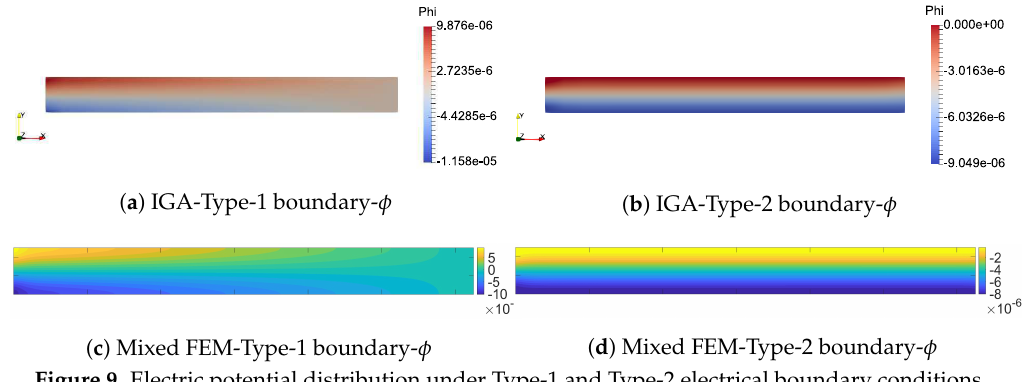
Figure 9. Electric potential distribution under Type-1 and Type-2 electrical boundary conditions.